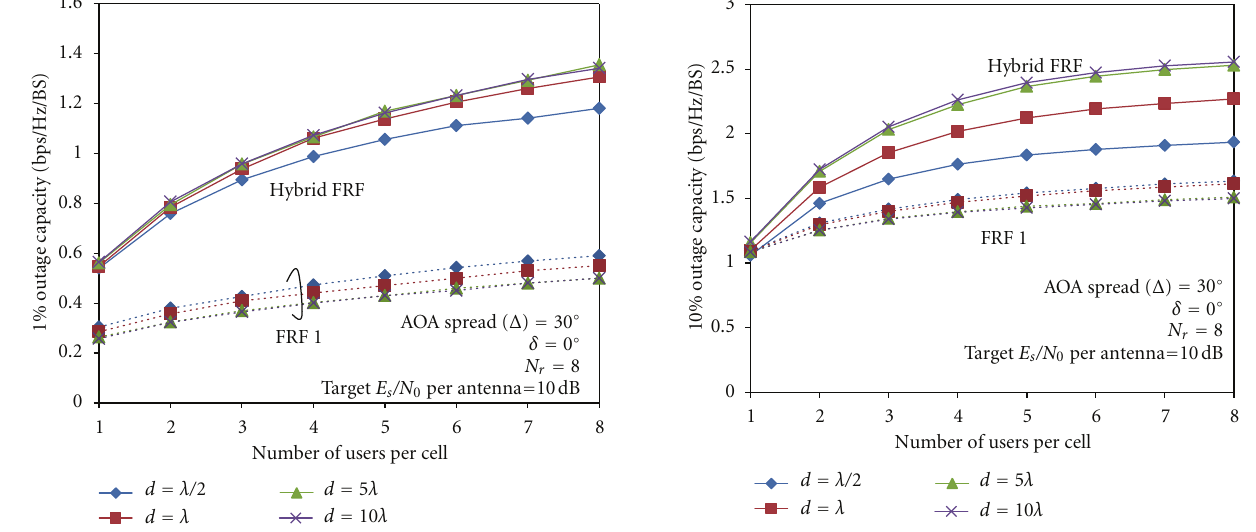
Figure 11: Cellular outage capacity with 1% outage probability.